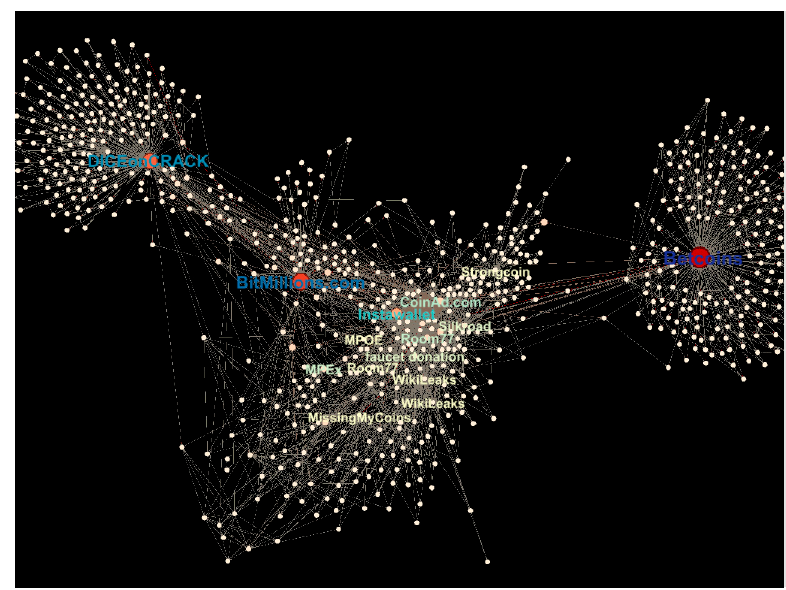
Figure 40. Betweenness Centrality in the Bitcoin Network.